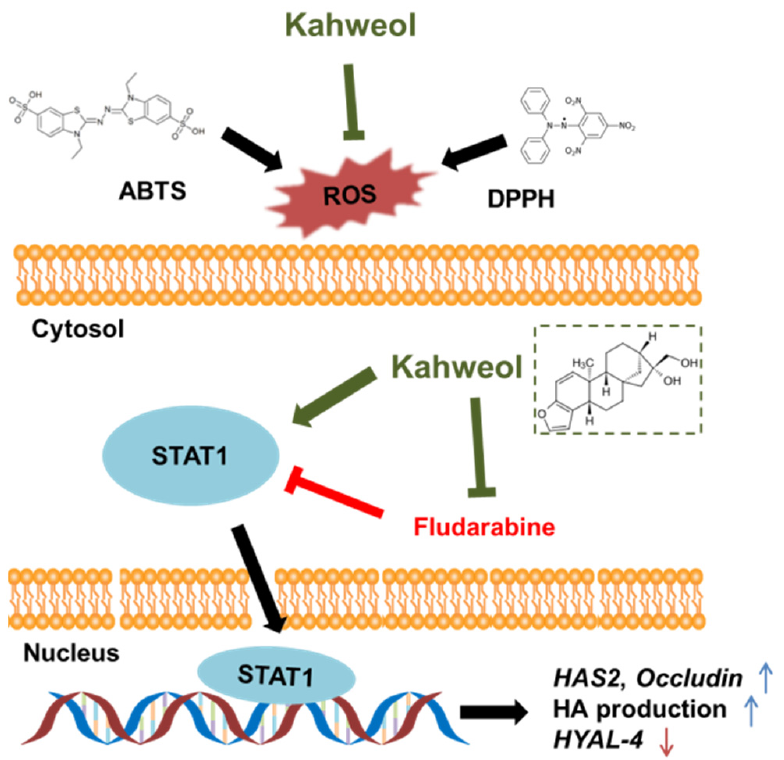
Figure 4. Schematic representation of molecules regulated by Kahweol.